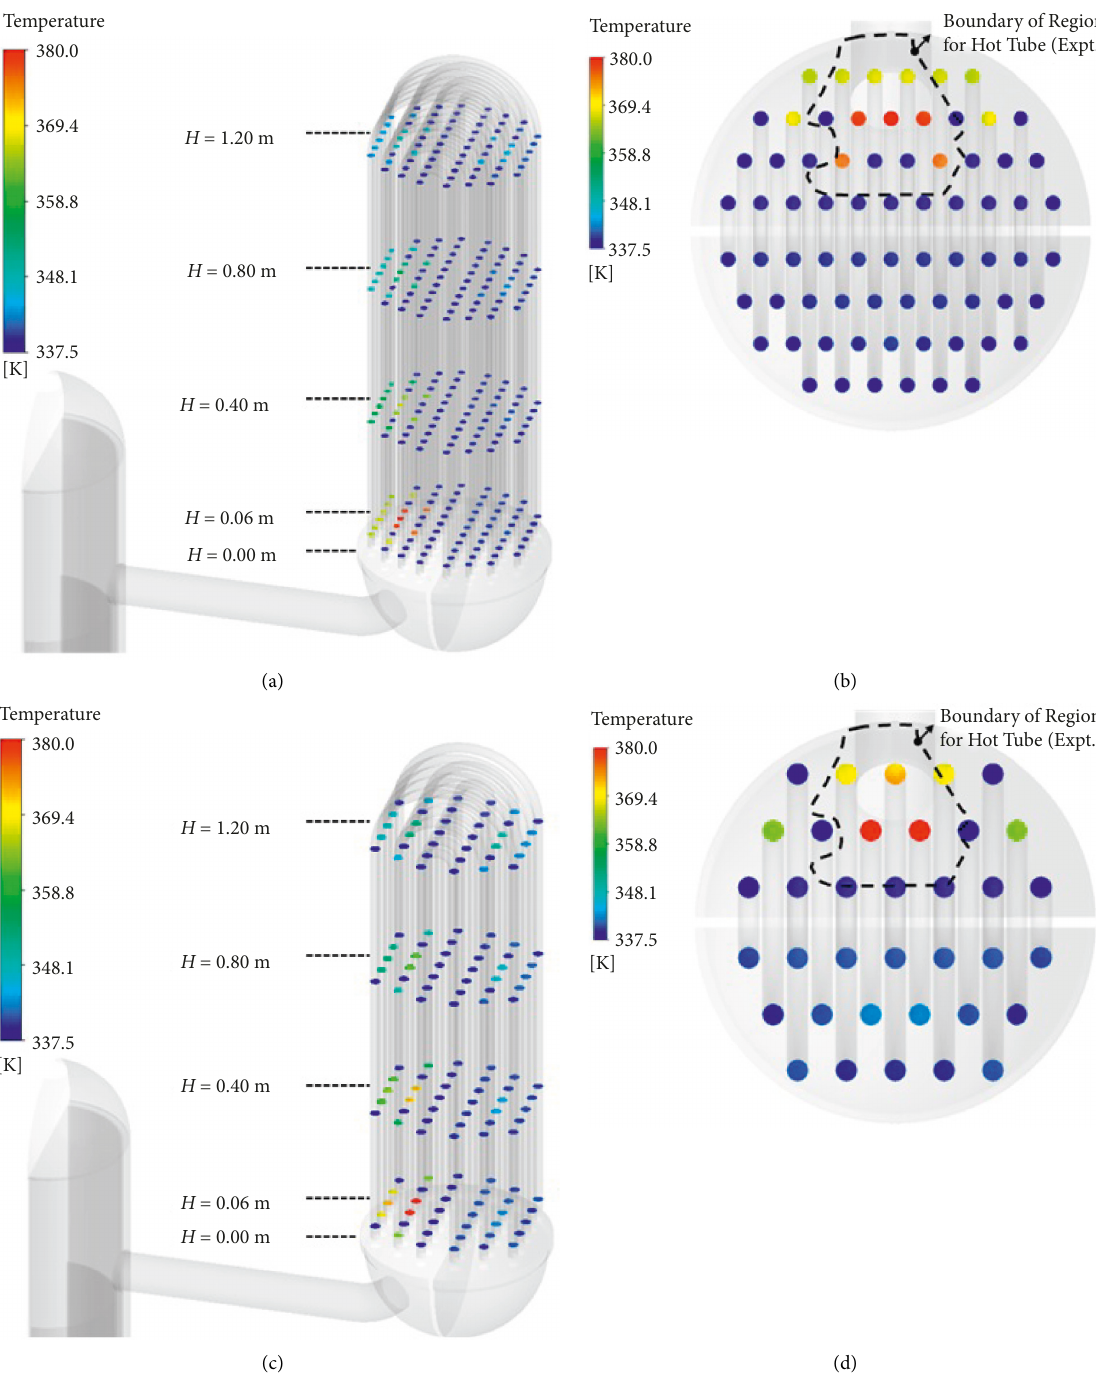
Figure 15: Temperature distribution on the vertical plane (models 2 and 3). (a) Model 2 (isometric view), (b) model 2 ( H � 0.06m), (c) model 3 (isometric view), and (d) model 3 ( H � 0.06